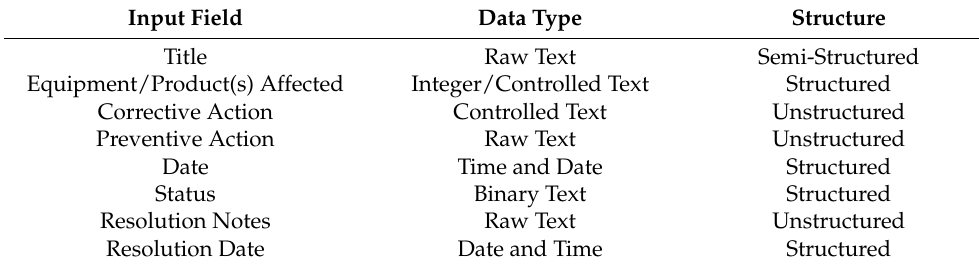
Table 2. Example of typical CAPA report data entry